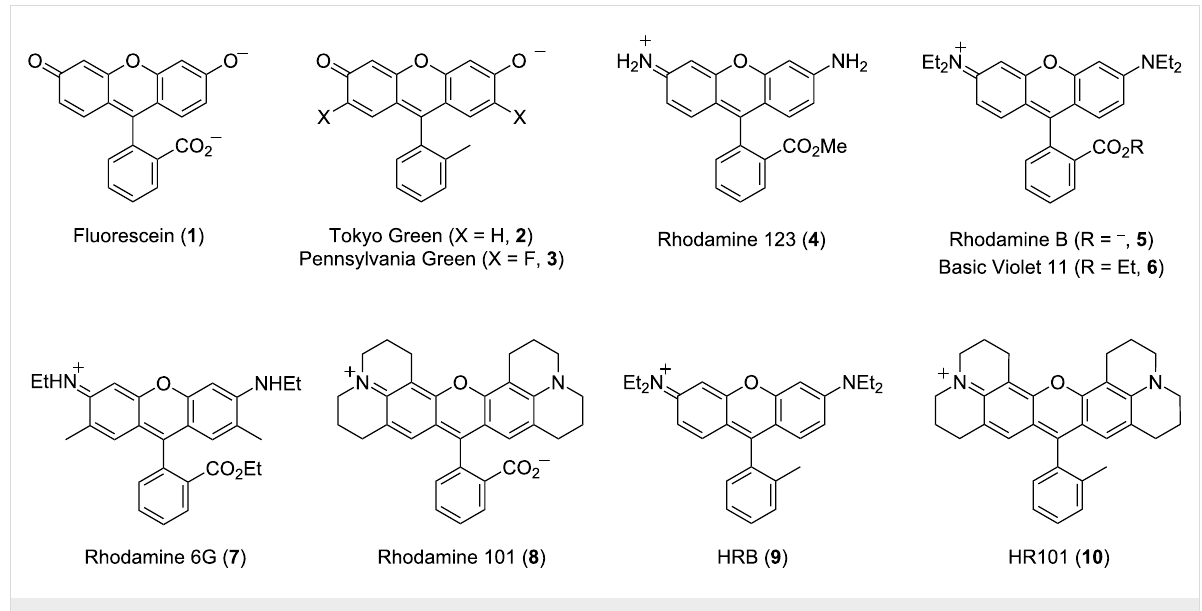
Figure 1: Structures of known fluorophores ( 1 – 8 ) and novel hydrophobic analogues of rhodamine (HRB, 9 , and HR101, 10